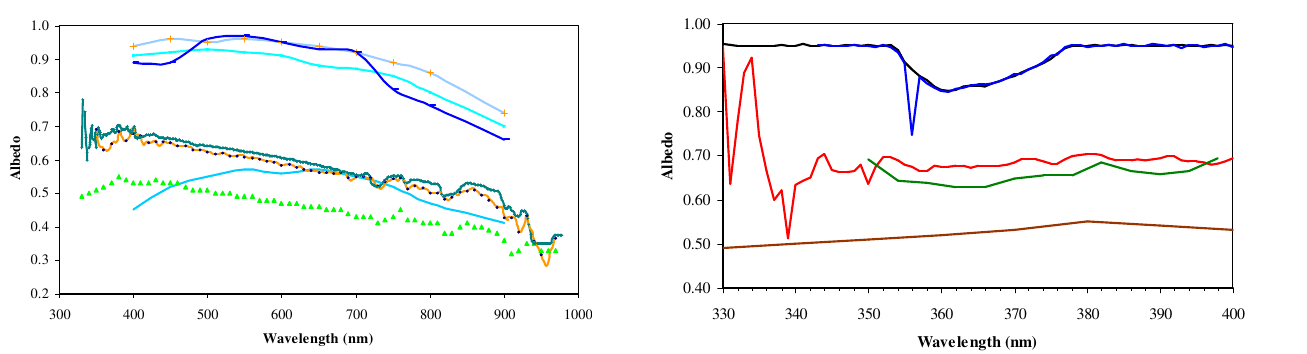
Figure 8. Spectral dependence of the snow albedo (Lake Ladoga) under different snow and sky conditions in the UV region: 26 March 1984 (black line, fresh snow, 330–400nm), 14 April 1985 (blue line, wet snow, 343–400nm), 20 April 1985 (green line, cloudy, wet snow, 350–398nm with a step of 4nm), 28 April 1985 (red line, wet snow, 330–400nm), and 29 April 1985 (brown line, wet snow, 330–400nm, with a step of